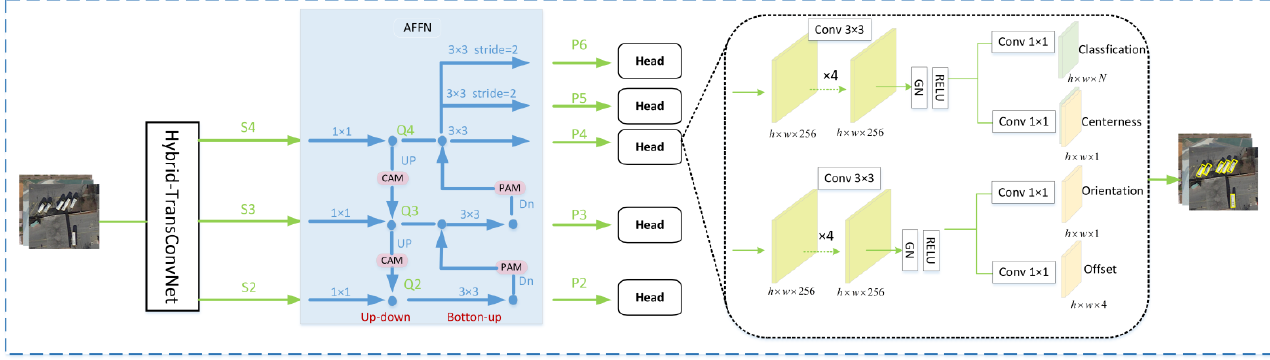
Figure 1. Framework of our method. The backbone network and AFFN is followed by multi-task prediction head.